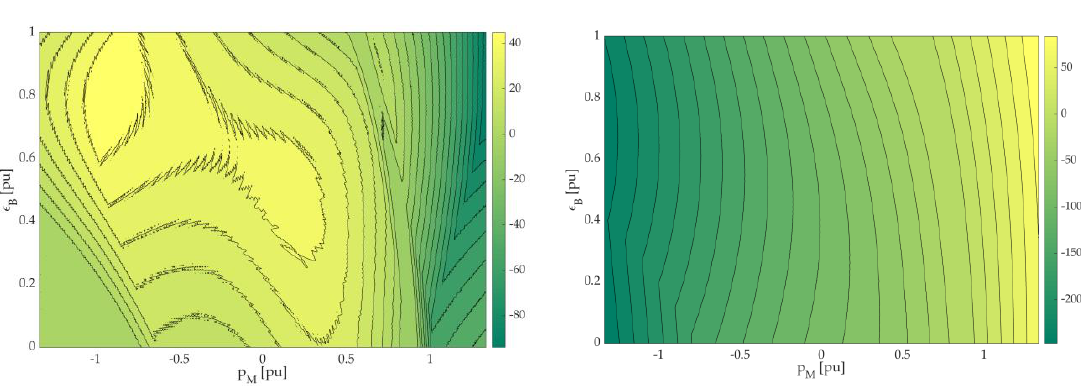
Figure 12. Differences between optimal i FC ( left ) and i B ( right ) loci (in A) on the ( p M , ε B ) plane achieved by A-EMS for v B = 0 and S-EMS.